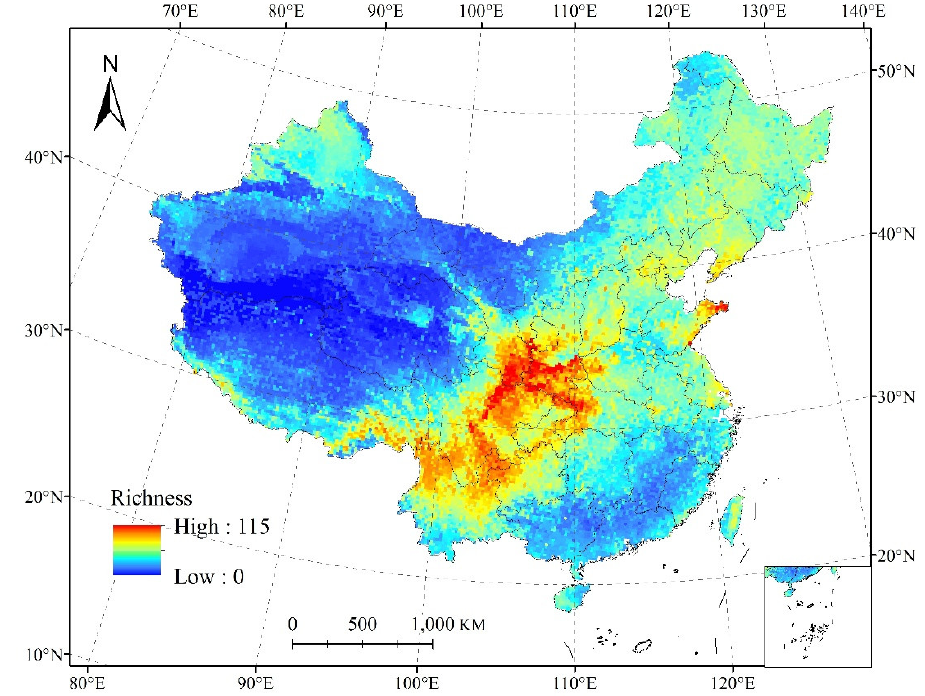
Figure 4. Species richness pattern of Salicaceae plants in China (using 20 × 20 km). The map was plotted using ArcGIS v10.2.